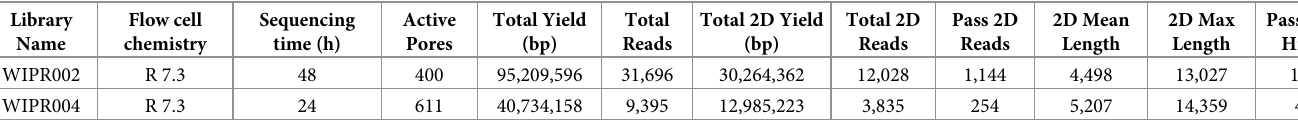
Table 1. MinION sequencing statistics.